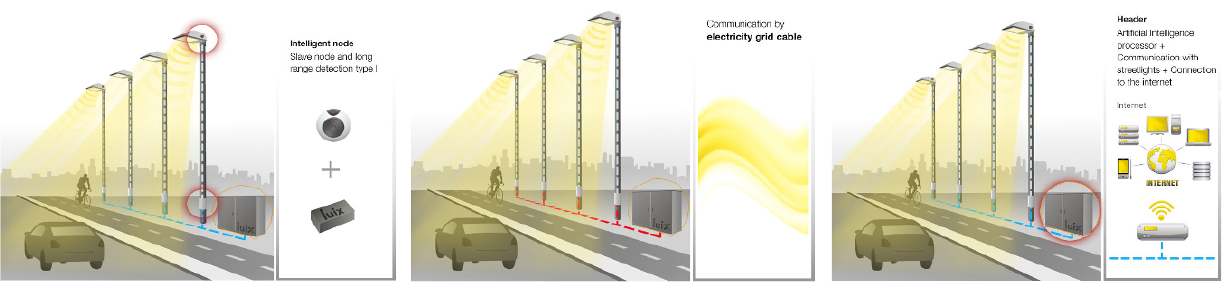
Figure 6. iiLUIX: how the system works